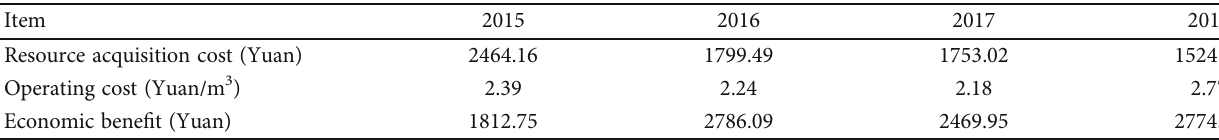
Table 9: Evaluation index values of economic list.